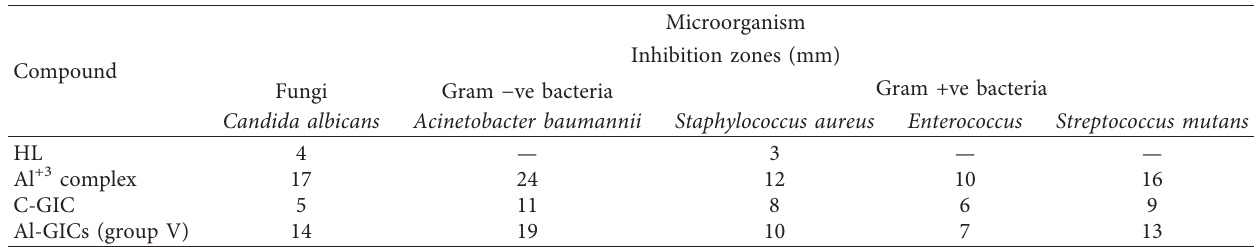
Table 3: Antimicrobial activity (inhibition zones in mm) of HL, Al +3 complex, C-GIC, and Al-GIC (group V) against the investigated microorganisms.